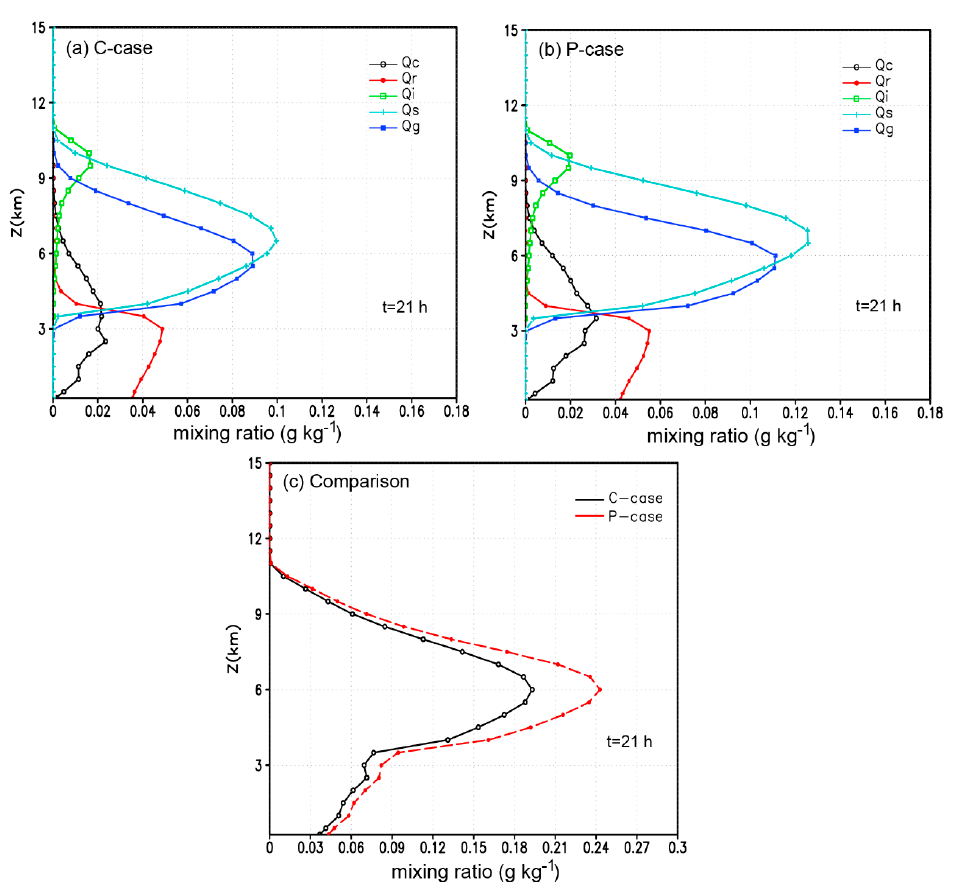
Figure 7. Same as Figure 5, but for t = 21 h.